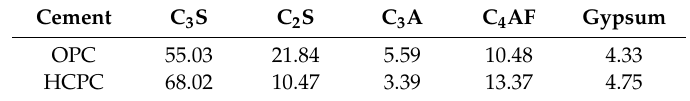
Table 2. Mineral compositions of the two di ff erent cement specimens